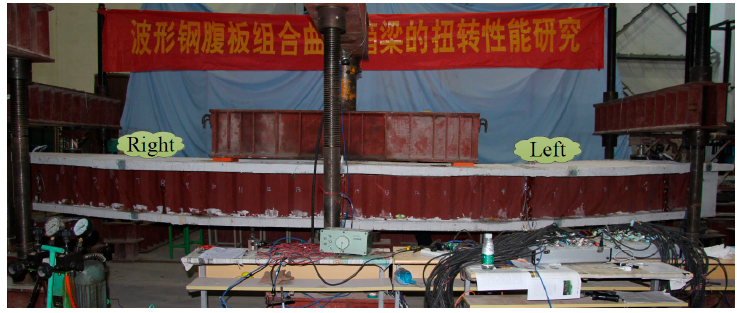
Figure 13. The final deformed shaped of specimen S1-t1d2.